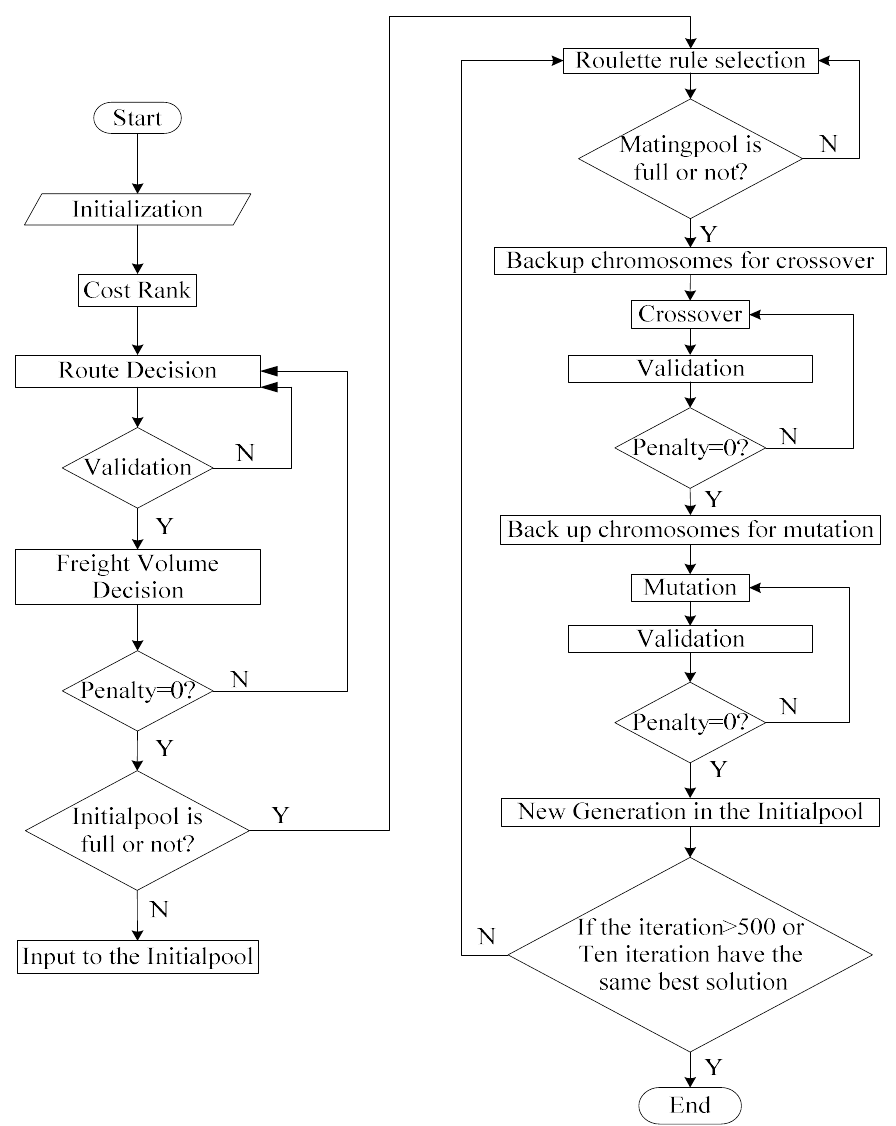
Figure 3. The flow diagram of two-stage priority based genetic algorithm (GA).